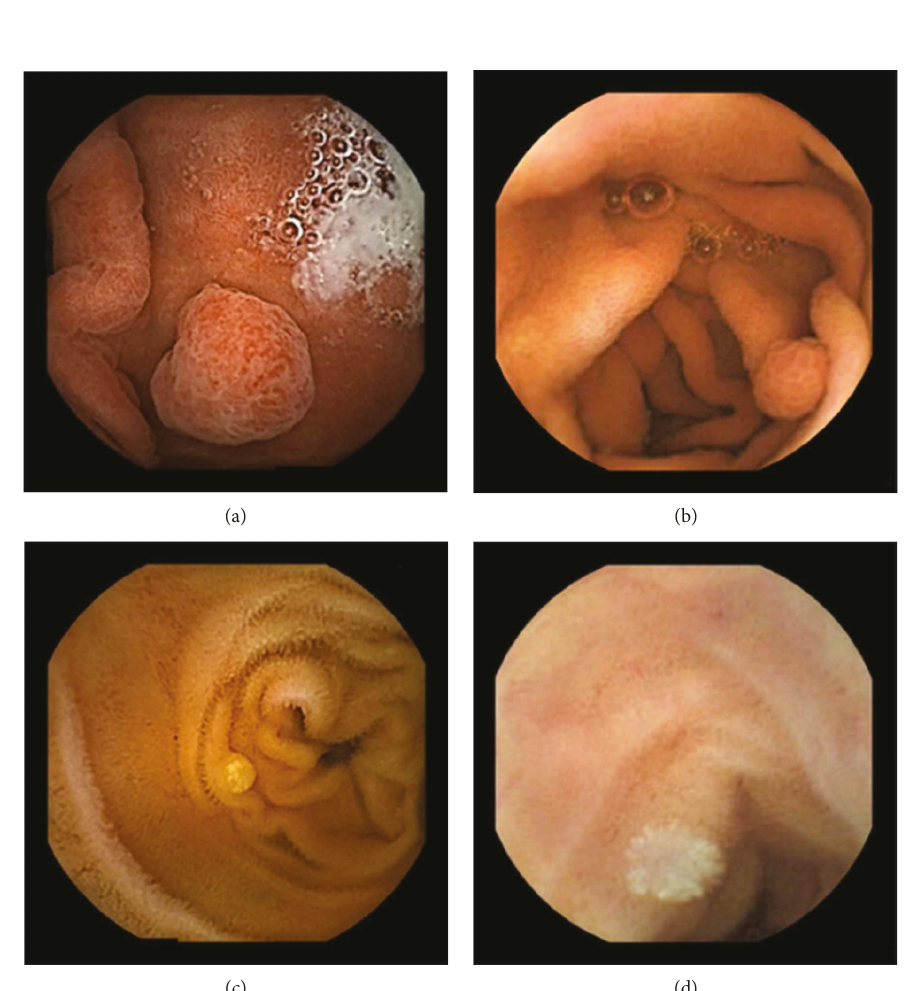
Figure 1: Examples of concordant cases. The MiroCam and PillCam SB3 revealed a polypoid mass in the proximal jejunum (a and b) of patient 2 and a polypoid mass in the distal ileum (c and d) of patient